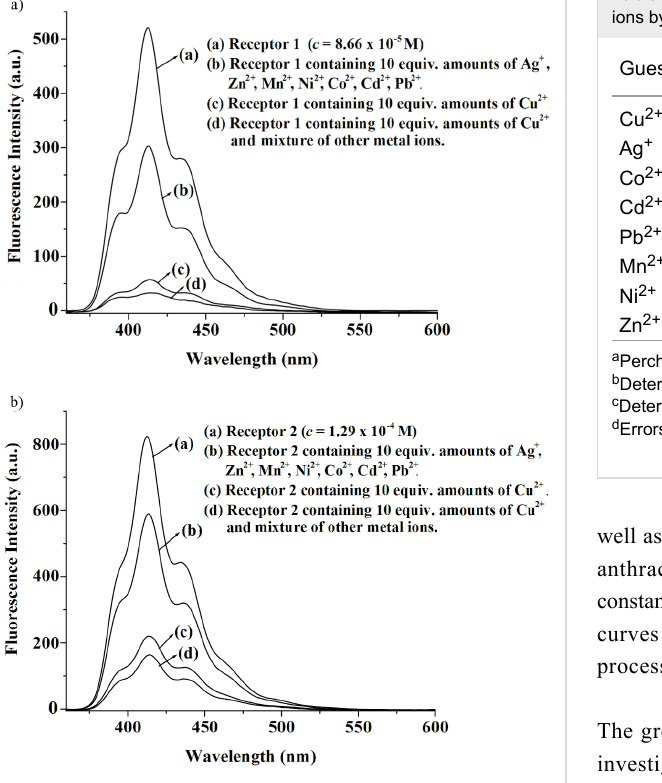
other metal ions. A similar feature is noted for 2 but the effi- ciency in selectivity is found to be less when compared to 1 .